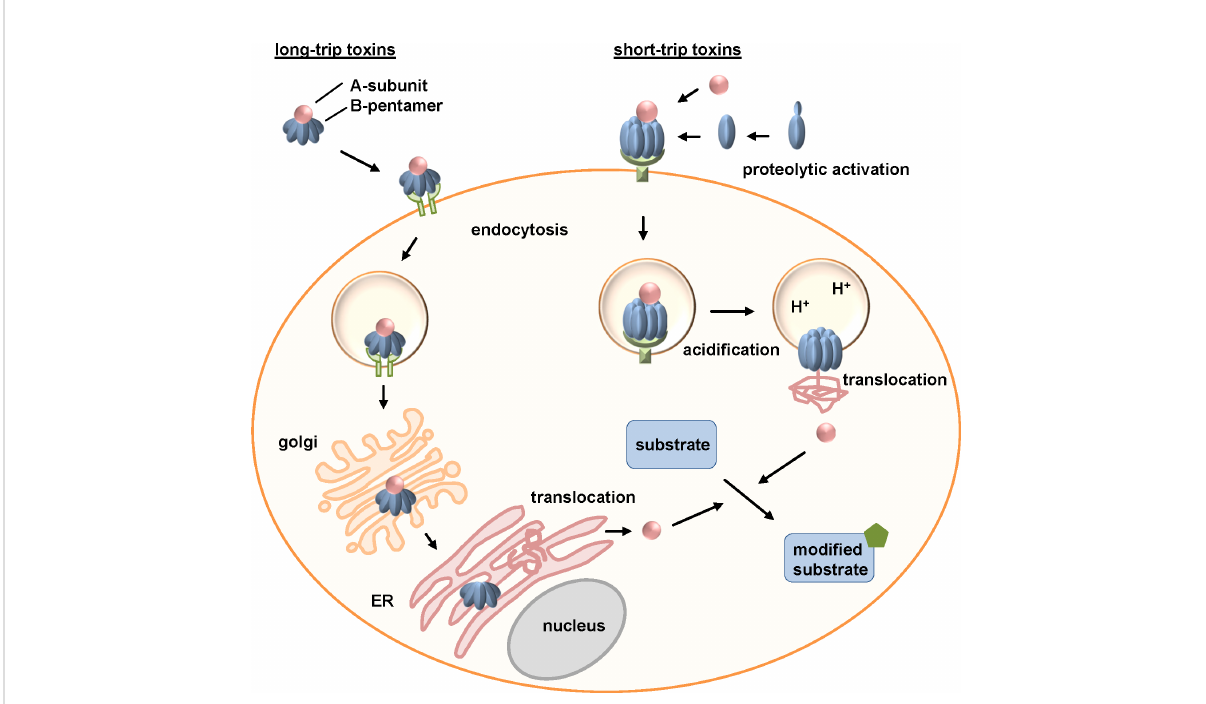
FIGURE 2 Uptake and intracellular routes of bacterial AB-type toxins. Long-trip toxins that for example comprise the AB 5 -toxins pertussis and cholera toxins (exemplarily depicted in this fi gure), bind to a cellular receptor via their B-subunits. After receptor-mediated endocytosis, long-trip toxins travel through the Golgi to the ER. Here, the enzyme subunit is released, unfolds and is transported via the ER-associated degradation (ERAD) pathway into the cytosol. Short-trip toxins, including amongst others clostridial binary toxins (exemplarily depicted in this fi gure) and diphtheria toxin, also bind to a receptor on the cell surface followed by receptor-mediated endocytosis. Acidi fi cation of endosomes leads to pore formation of the B-subunit due to conformational changes and unfolding of the A-subunit. The enzyme subunit translocates through the pores into the cytosol of cells. Here, long- and short-trip toxins enzymatically modify their speci fi c substrates causing cellular effects and thereby clinical symptoms of the respective disease (Barth et al., 2004; Wernick et al., 2010; Barth and Ernst, 2016; Teter,